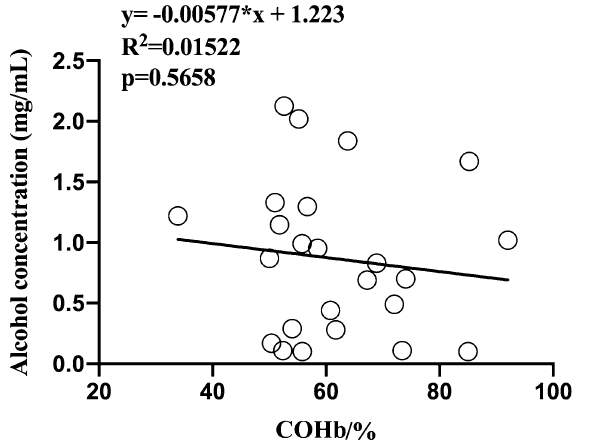
Figure 4. Correlation between COHb saturation and blood alcohol concentration in the fire-unrelated poisoning case.